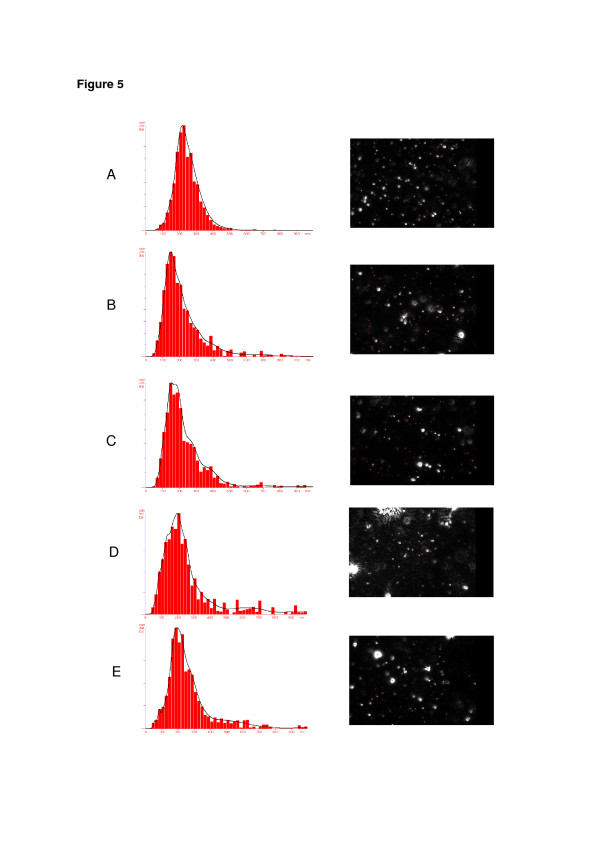
Particle size distribution (nanometers) (left) and sample video frame (right) obtained from NTA. (a) Original NC; (b) redispersed D-NC-L at time 0; (c) redispersed D-NC-L after 60 min; (d) redispersed D-NC-M at time 0; and (e) redispersed D-NC-M after 60 min.